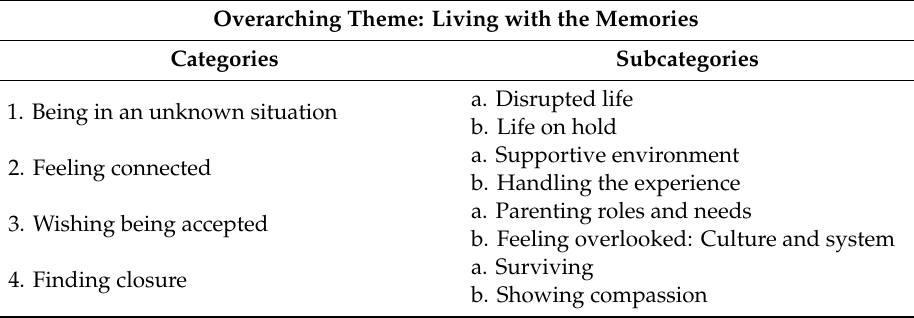
Table 3. Overarching theme, main categories, and